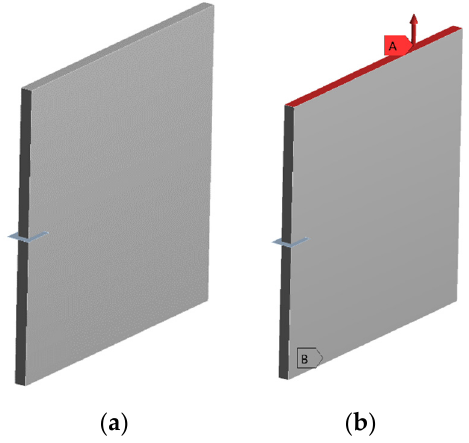
Figure 12. Test plate: ( a ) test plate with a rectangular crack shape in the middle of the specimen; ( b ) test plate with the normal force applied on the top surface (A) and constrained at the opposite surface (B).